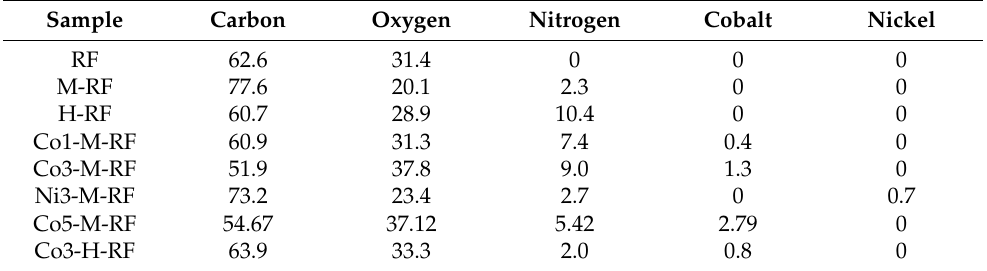
Table 1. Elemental analysis of various catalyst compositions (all figures in